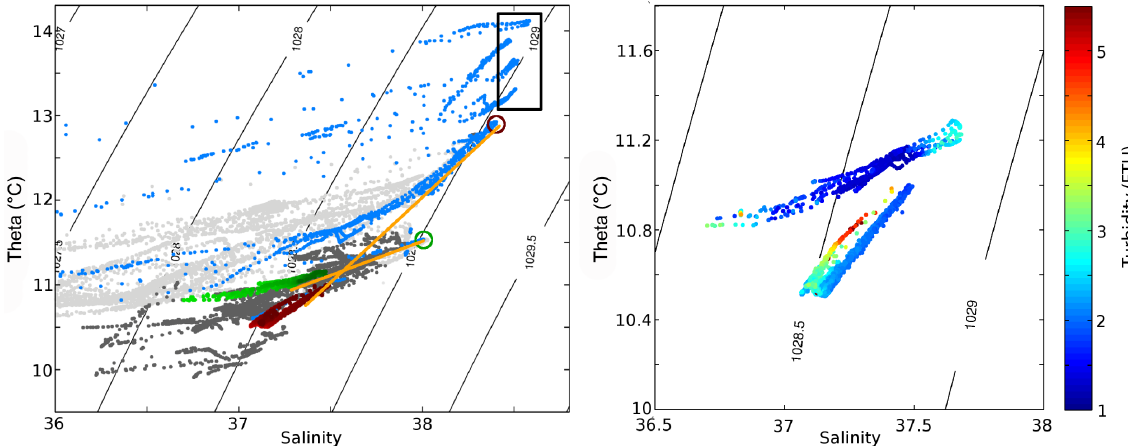
Figure 4. (Left panel) θ – S plot of all CTDs and MSSs (both ISMAR and NIB) casts (light grey for the northern Adriatic and dark grey for the GoT). The green and red dots are the MSS-ISMAR and MSS-NIB ensemble means for Y02 and Y03, respectively, light colour for surface values and dark colour for bottom ones. The green circle indicates the bottom waters observed at the entrance of the GoT on 30 January that are the end point for Y02 bottom waters; red circles point to deep waters outside the GoT on 4 January considered as the end point of Y03 bottom water. The black square encompasses values in bottom waters in the centre of the North Adriatic Sea. Locations of end points are shown in Fig. 1. The profiles of the cast leading to the end points are shown in light blue. (Right panel) θ – S plot for Y02 and Y03. Colour scale shows turbidity FTUs (formazin turbidity units) as measured by the back scatterometer mounted on the MSS ISMAR probe.